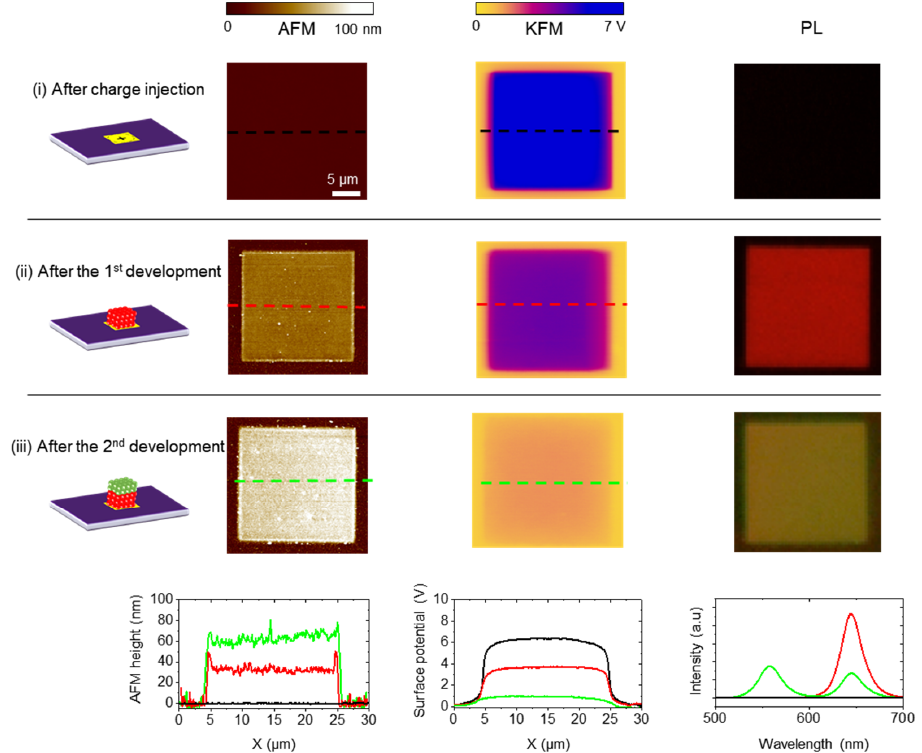
Figure 3. Atomic force microscopy (AFM), Kelvin Force Microscopy (KFM), and photoluminescence (PL) mappings at various stages of a vertical combinatorial assembly by AFM nanoxerography of red and green NPs on a 20 µm charged square pattern. The lateral scale is identical for all pictures. The corresponding AFM/KFM profiles and the PL spectra are reported in various colors depending on the protocol step: black after charge injection, red after the first assembly of red NPs, and green after the second assembly of green NPs.